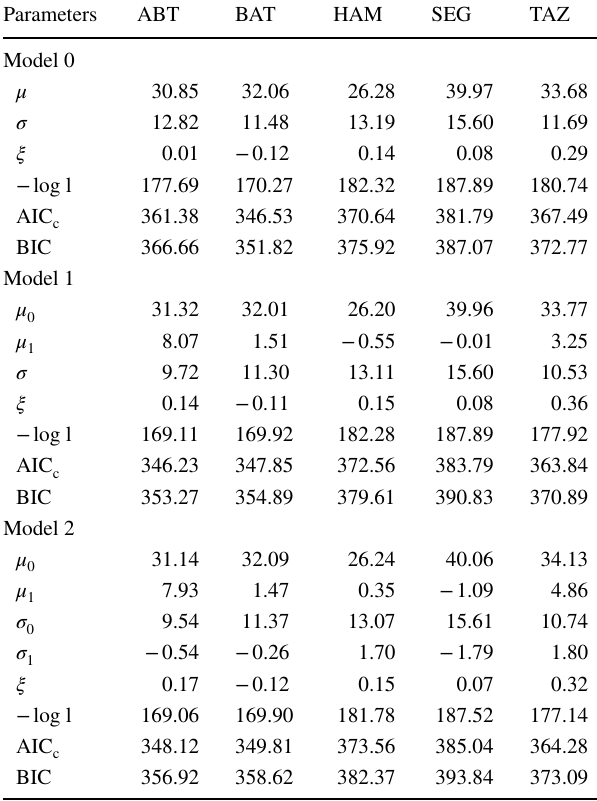
Table 5 Parameter estimates and summary of goodness-of-fit tests for three